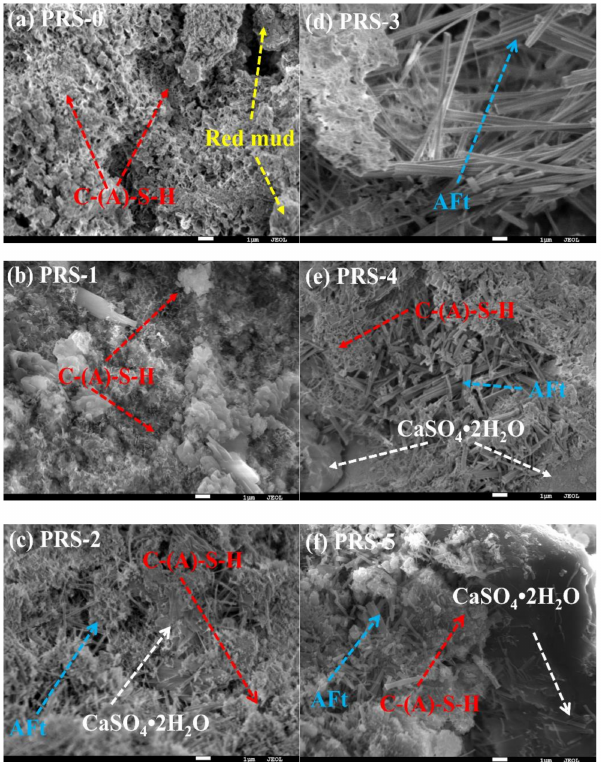
Figure 16. SEM images of ( a – f ) at the curing age of 28